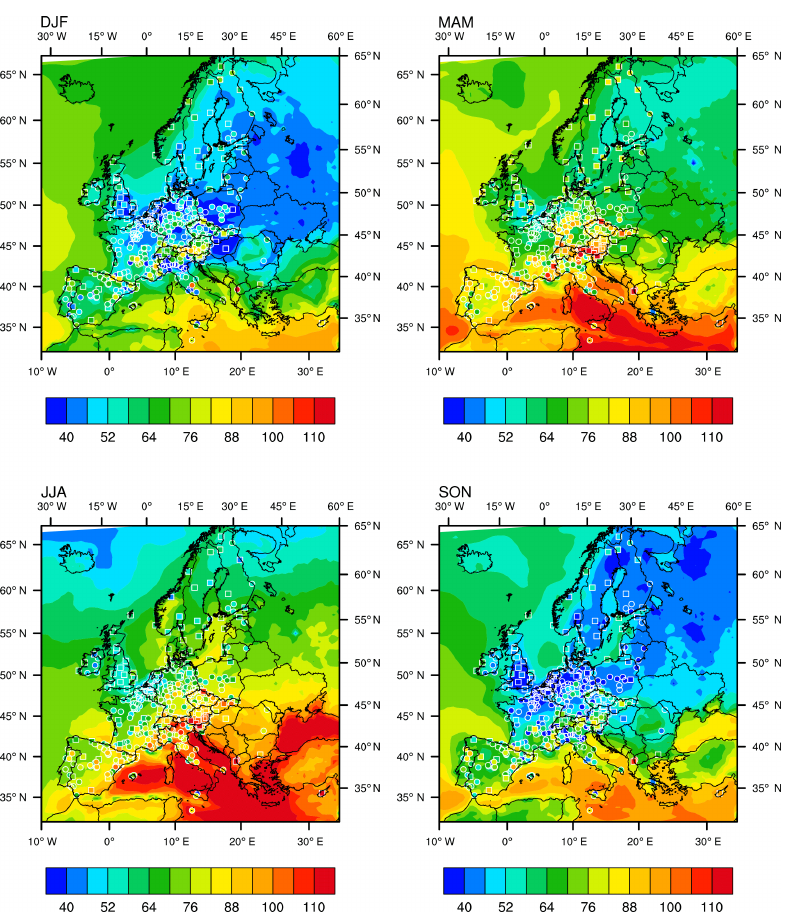
Figure 4. Seasonal average values of surface O 3 in µgm − 3 . Contours are model output from the MOZART simulation. Filled dots represent hourly measurements at AirBase rural background stations, filled squares represent measurements at EMEP